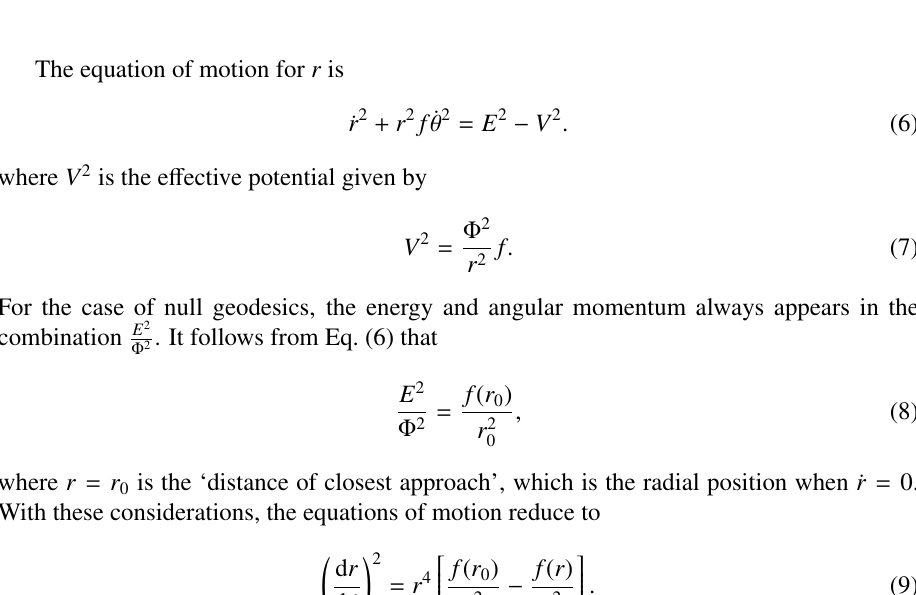
The equation of motion for r